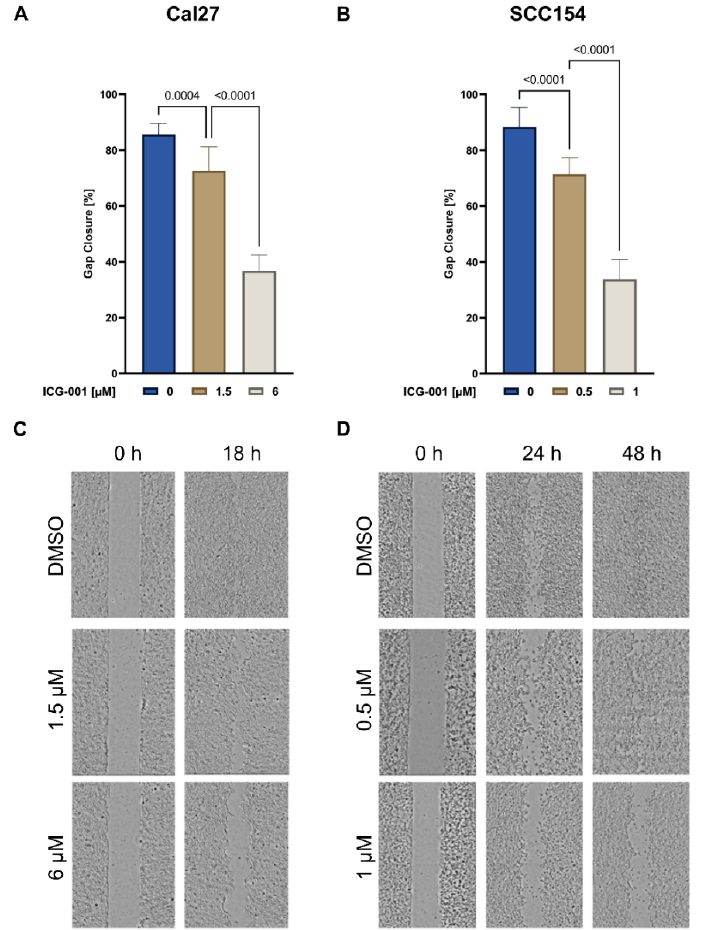
Figure 6. ICG-001 treatment reduces the migratory potential of HPV-negative and HPV-positive HNSCC cells. ( A , B ) Graphical illustration of the analyzed migration assay of Cal27 (0 and 18 h, ( A ) and SCC154 (0 and 48 h, ( B )) cells treated with ICG-001 or vehicle control (DMSO). With lower inhibitor concentrations, a similar anti-migratory effect was observed in the SCC154. ( C , D ) Visualization performed with the TECAN reader for Cal27 ( C ) and for SCC154 ( D ) at the indicated time points. The free area was measured immediately after the gap generation, as well as after 24 h and 48 h in SCC154. Due to faster cell migration and gap closure, the second measurement was performed after 18 h in Cal27. Statistical differences between control and ICG-001-treated cells were assessed using the one-way ANOVA test. HPV; human papillomavirus, DMSO; dimethyl sulfoxide, SD; standard deviation.